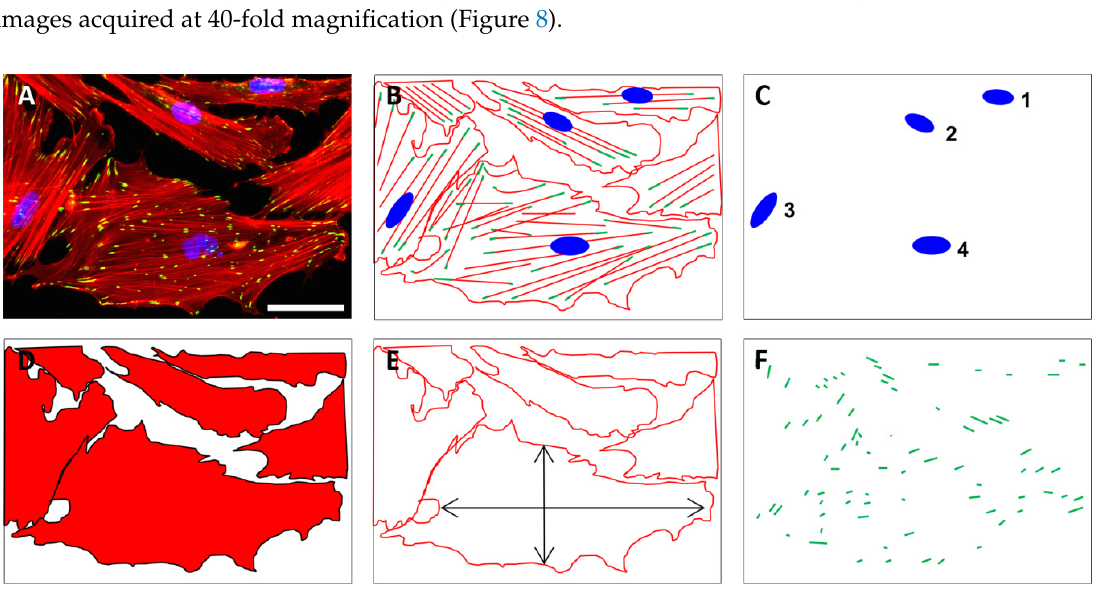
Figure 8. The quantification of cell numbers, cell area, aspect ratio, and focal adhesions on unstructured and structured surfaces was based on fluorescently stained cells. Exemplary fluorescence image of HGFib in the original ( A ) and in the schematic representation of stained cell components ( B ); the quantification of cell numbers was based on the DAPI-stained cell nuclei (blue) ( C ); the cell shape ( D ) as well as the aspect ratio of the cells ( E ) were derived from the staining of the actin fibers with phalloidin-TRITC (red); the pFAK antibody staining with DyLight488 (green) detection was used to determine the number, length, and composition of focal adhesion points ( F ). Scale = 50 µm.